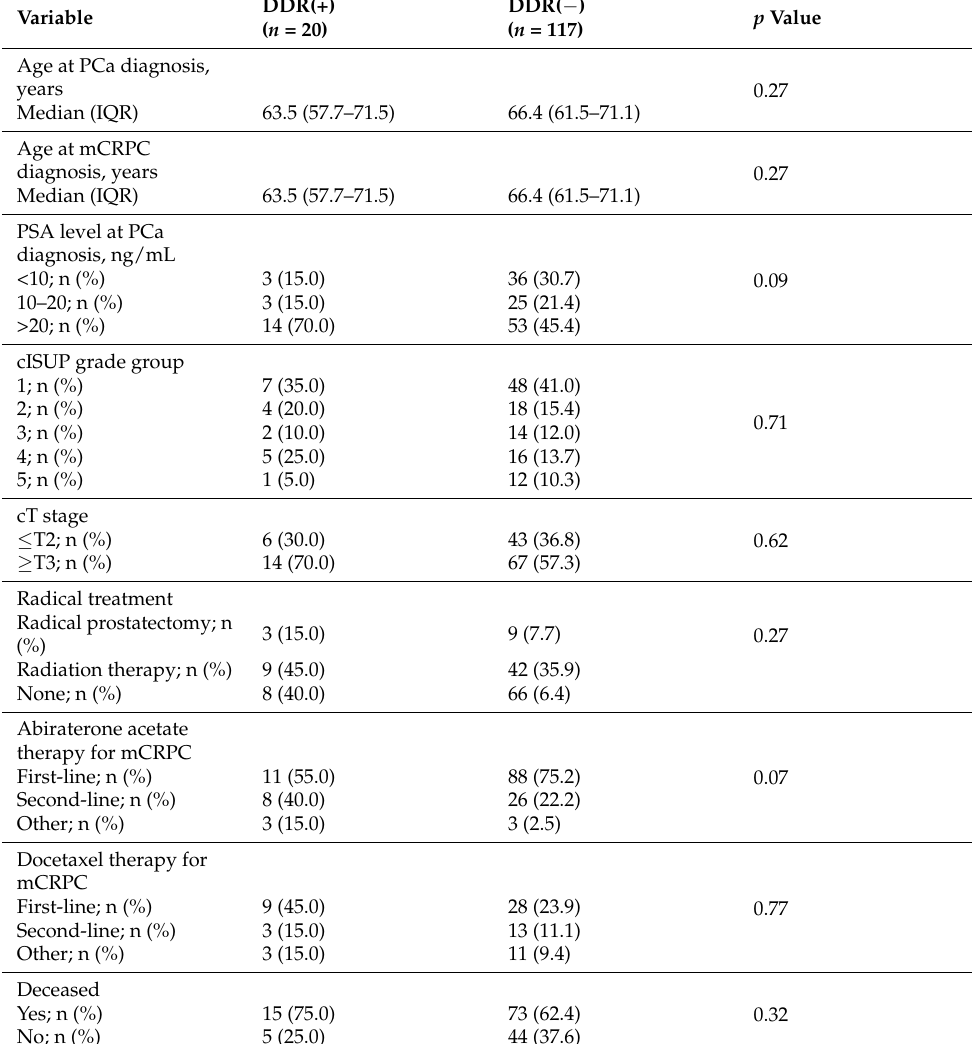
Table 2. Clinico-pathological and demographic characteristics of study